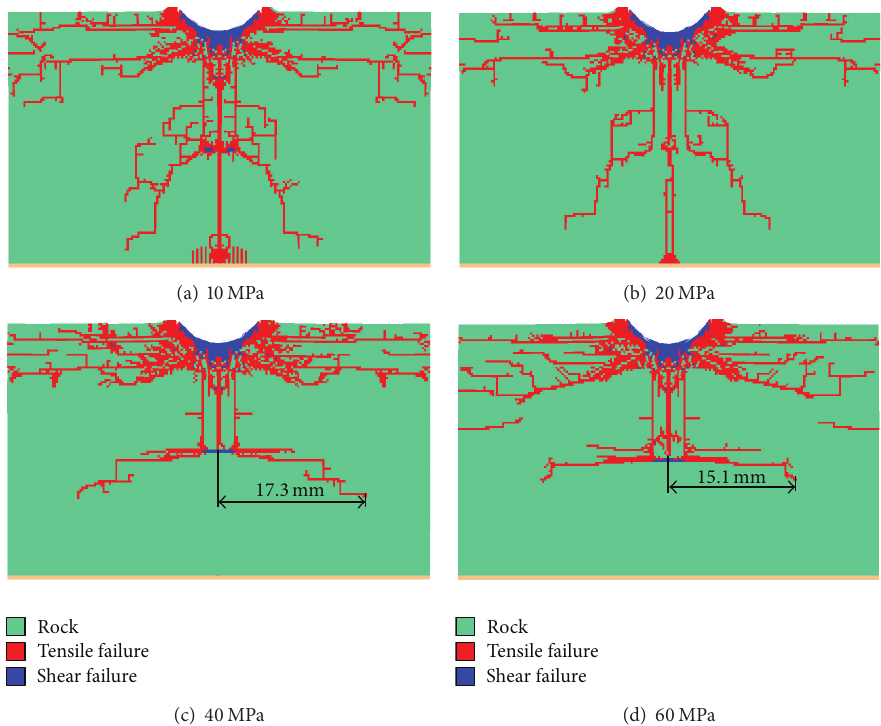
Figure 12: Rock fragmentation status with different confining